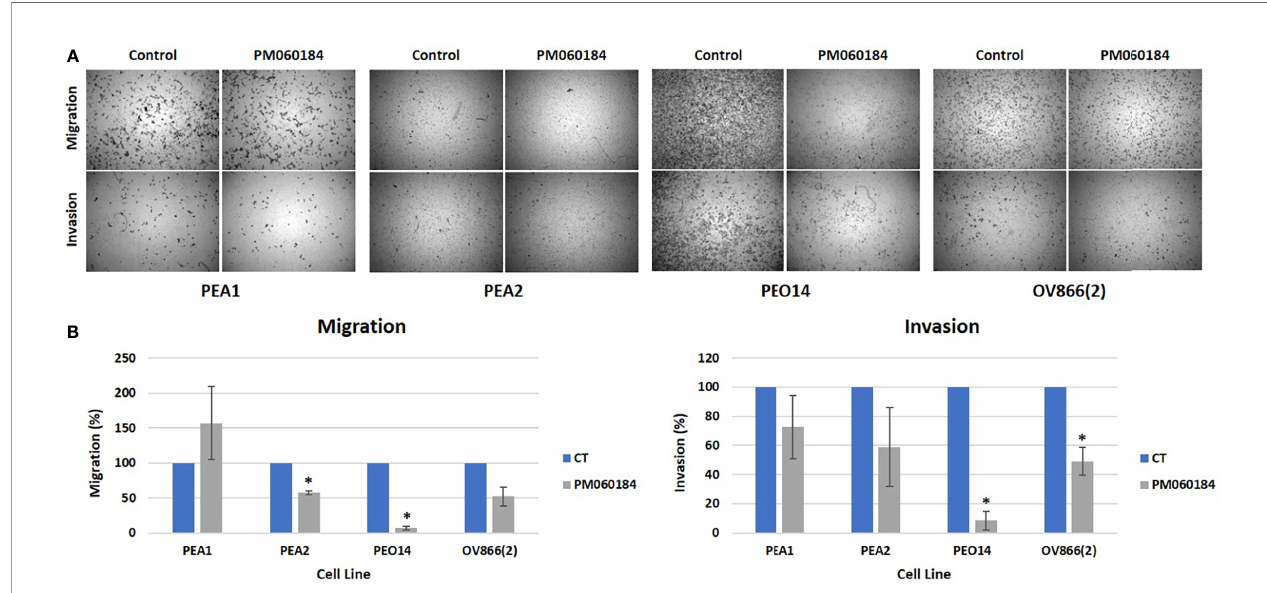
FIGURE 2 | Plocabulin effect on 2D migration and invasion. (A) Transwell migration and invasion images of a representative experiment of PEA1, PEA2, PEO14 and OV866(2) cells. (B) Bar plots represent the quanti fi cation of the data calculated with the mean values of at least two experiments. CT: untreated control; *: p value <